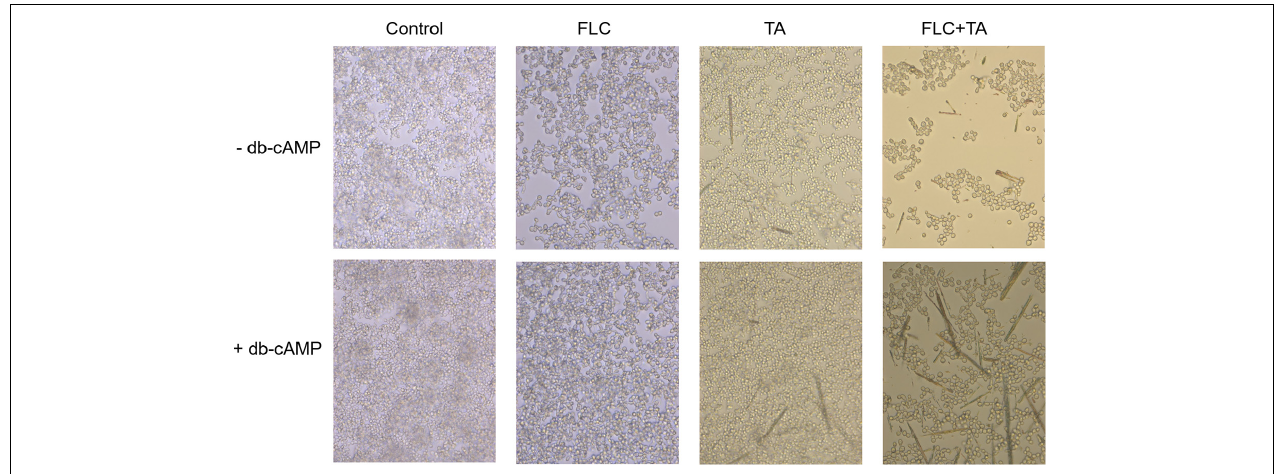
FIGURE 9 | cAMP is related to the formation of hyphae and biofilm of C. albicans . The exogenous cAMP restored the mycelium formation of C. albicans inhibited by TA combined with FLC (magnification of 400 × ).